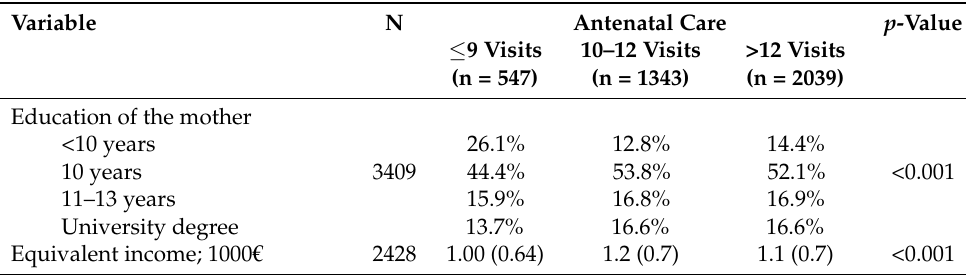
Table 2. Maternal socio-economic characteristics in relation to participation in medical check-up during pregnancy in the SNiP-I cohort from 2004 to 2008.